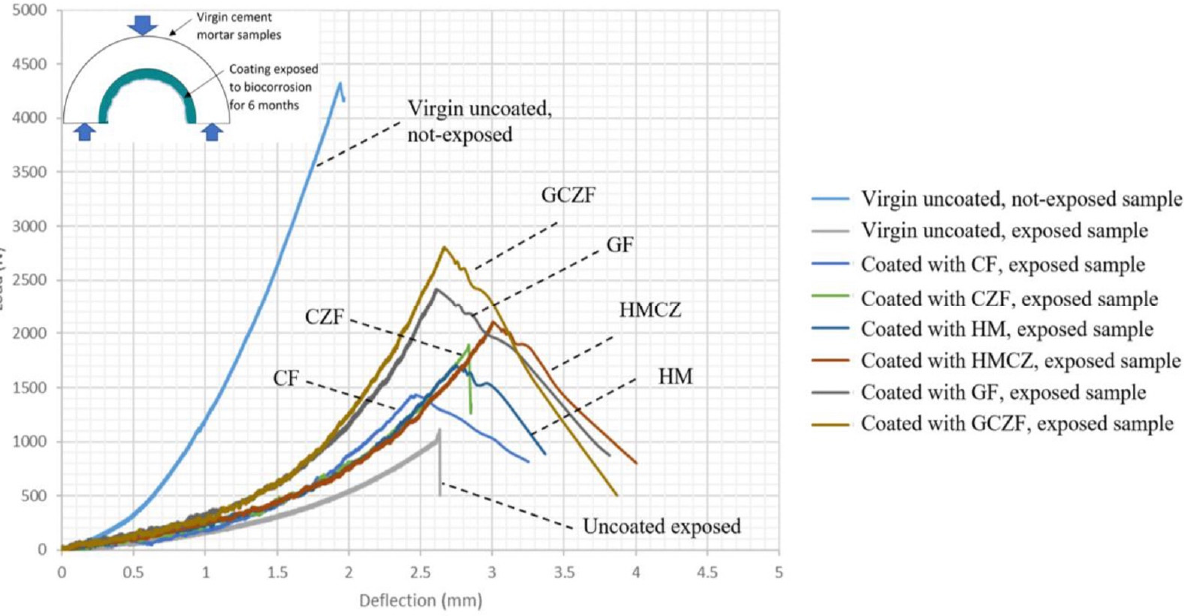
Figure 12. Effect of corrosion on the ultimate load-bearing capacity of different virgin coated samples [1].